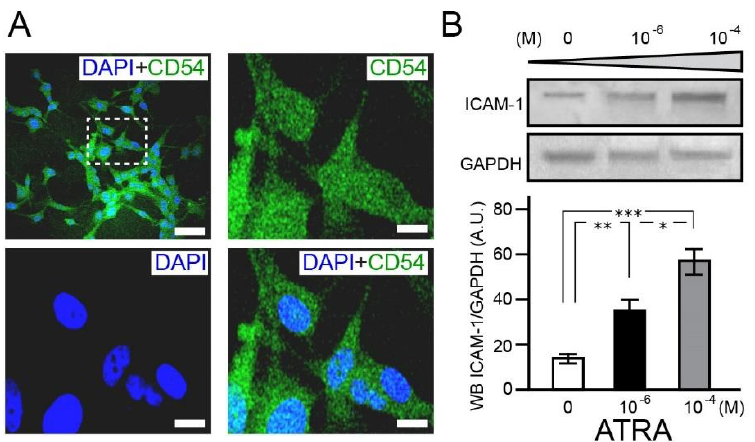
Figure 2. Intercellular adhesion molecule 1 is located in the nucleus and cytosol with increased expression in response to ATRA. Confocal micrographs of U87MG showing immunohistochemical detection of ICAM-1 (CD54; Alexa fluor 488; green) and nuclear stained DAPI (blue) ( A ) after 7 days of ATRA (10 −4 M) treatment. Scale bar 100 µm. White dashed box region (( A ), upper left) is shown in higher magnification (×40, ( A )) to highlight the presence of ICAM-1 in the nucleus and cytosol. Scale bar 20 µm. Representative Western blot (upper ( B )) and analysis (lower ( B )) indicates the incremental increased expression of ICAM-1 in response to higher ATRA concentrations. Asterisks represents p < 0.05 significance, n = 2.